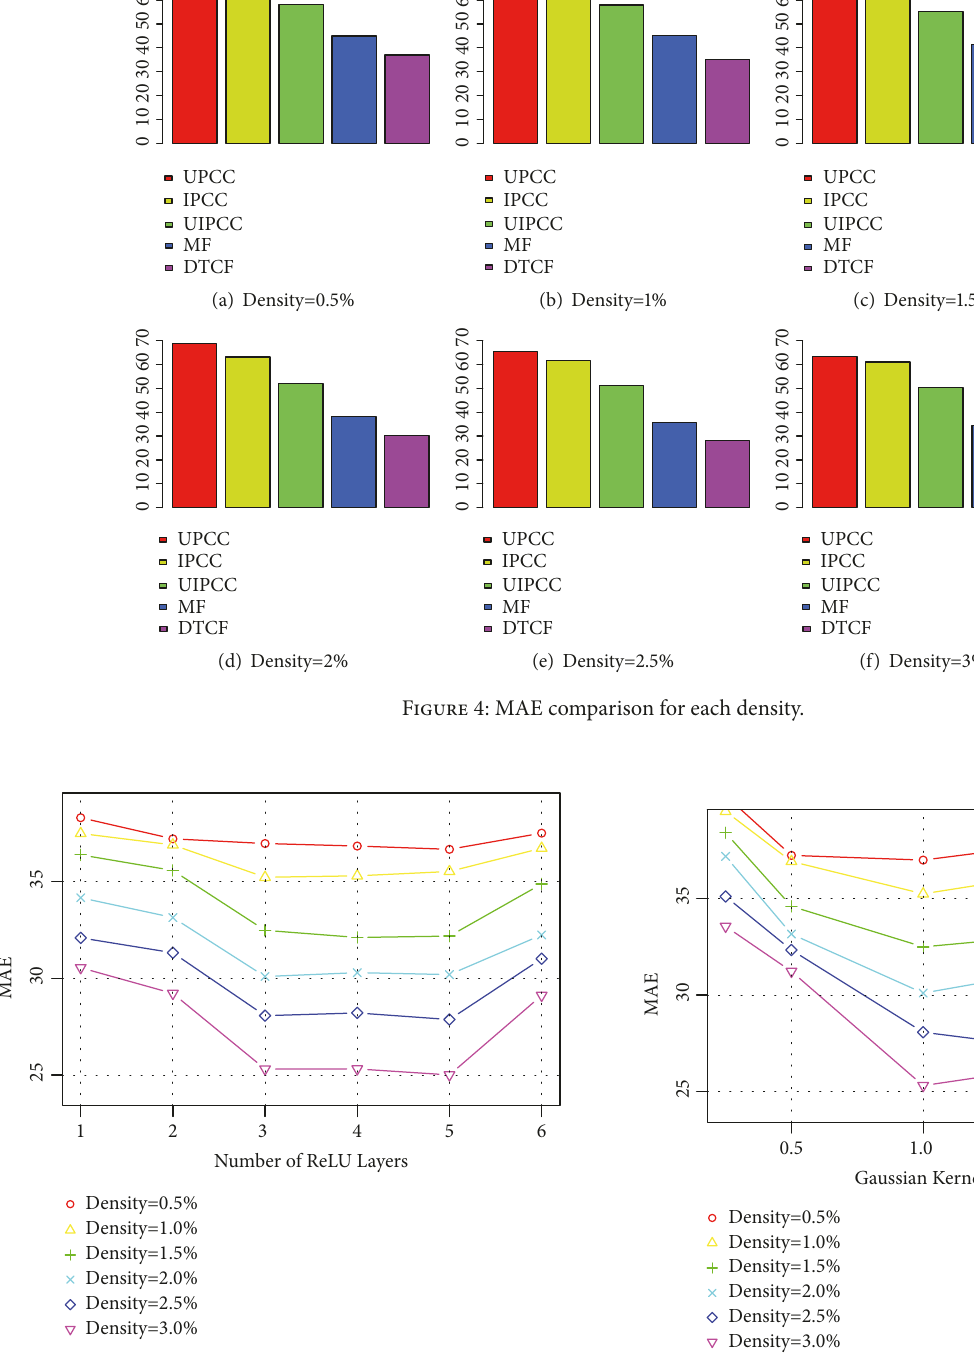
Figure 6: MAE with respect to Gaussian kernel bandwidth scale.